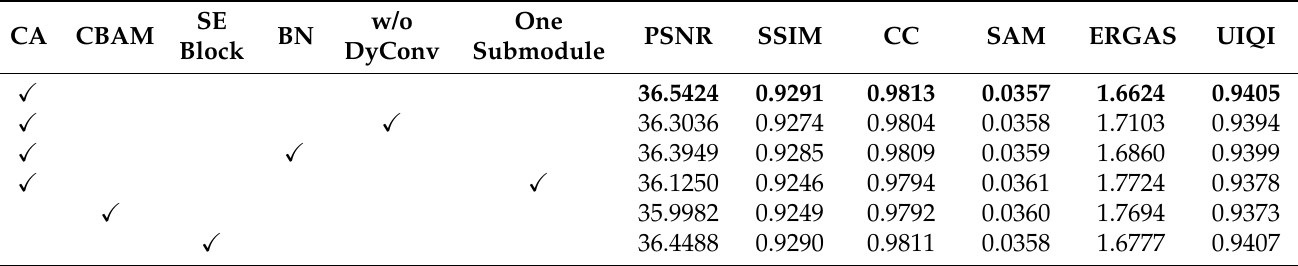
Table 7. Ablation study of the proposed MDCDB with different structures on the QB dataset. The best performance is shown in